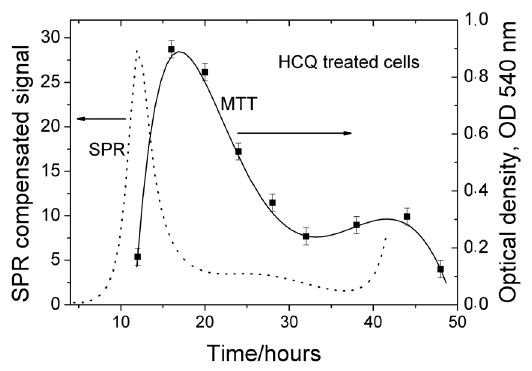
Figure 8. Kinetics of HCQ activity: dotted line—SPR results; solid line—MTT results. The experiment involved Vero E6 cells (3 × 10 4 cells/mL) infected with HCoV-229E (MOI = 0.1) and treated with an HCQ standard (Sigma-Aldrich) at a concentration of 1